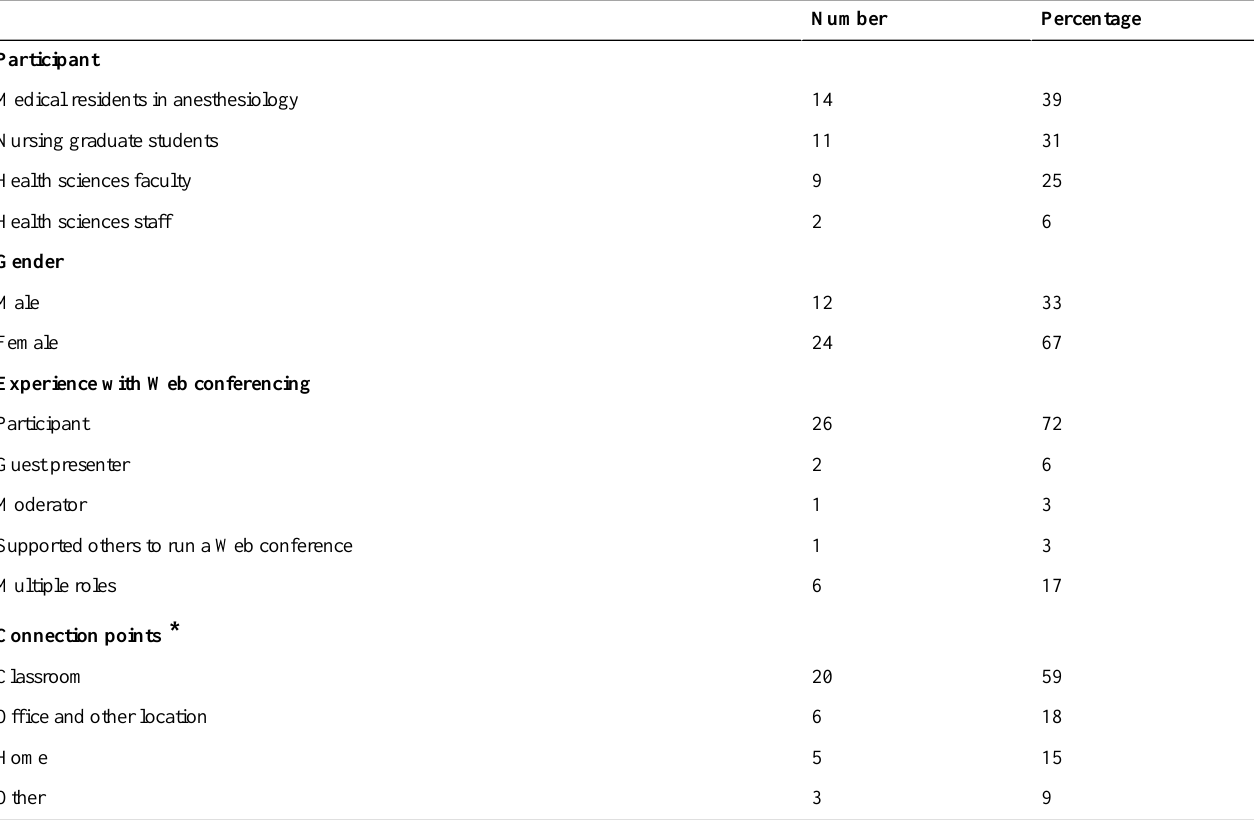
Table 1. Description of participants (N =